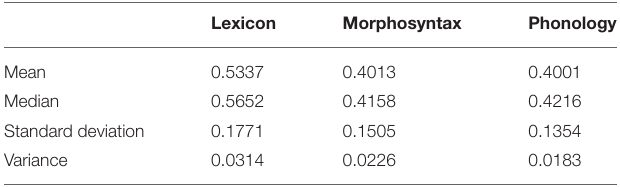
TABLE 3 | Descriptive statistics of each linguistic level’s linguistic distance